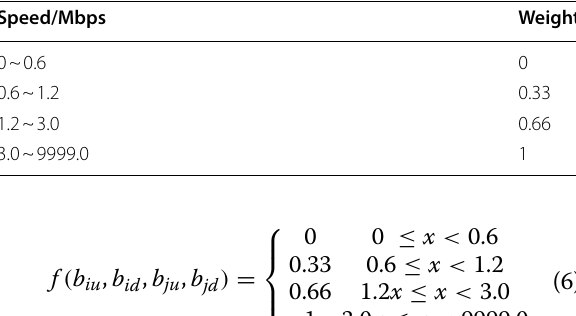
Table 1 Weights based on zoom bandwidth